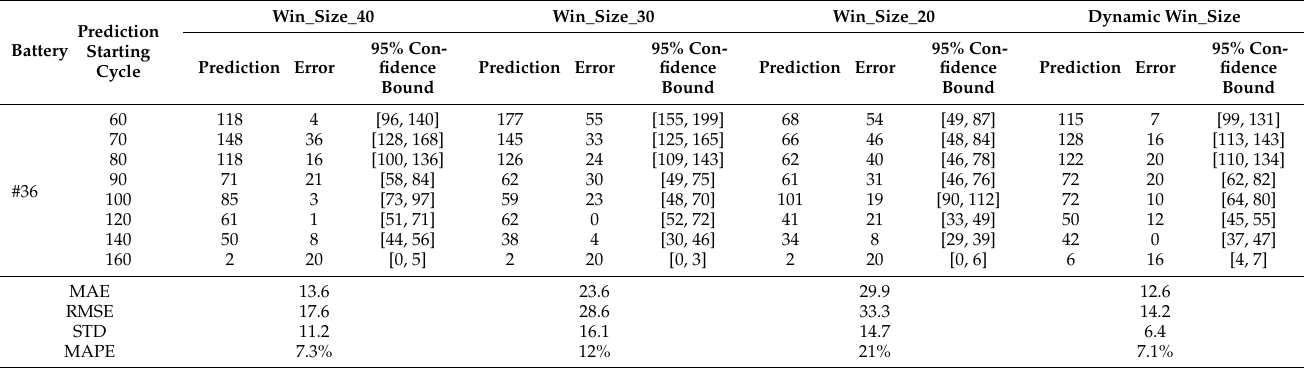
Table A3. Details of the RUL prediction results of No. 36 with different window